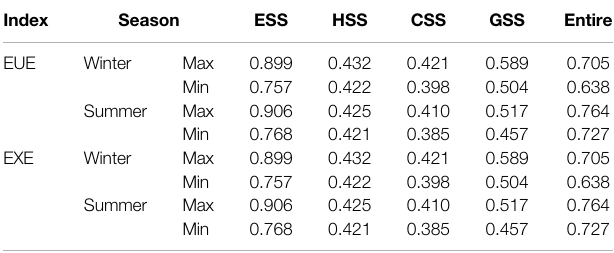
TABLE 8 | The energy ef fi ciency of